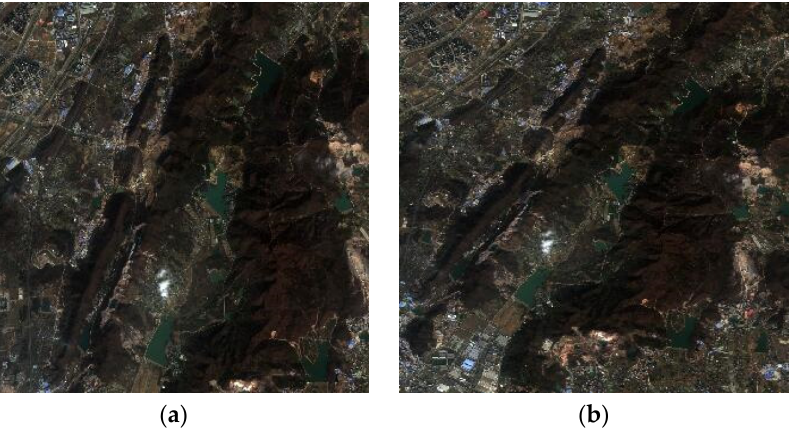
Figure 2. Comparison of multispectral images before and after preprocessing. ( a ) Multispectral image before preprocessing; ( b ) multispectral image after preprocessing.